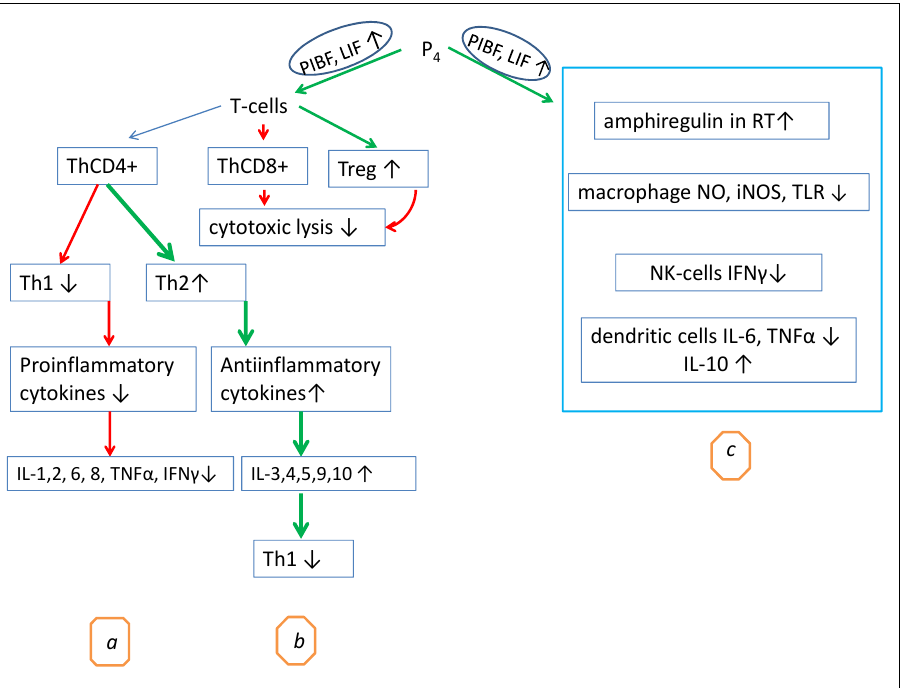
Figure 1. The proposed mechanisms of the P4 immunomodulatory effects. ( a ) P 4 induces PIBF and LIF production, which inhibit the Th1 pathway and reduce the production of proinflammatory cytokines; ( b ) P 4 upregulates Th2 differentiation and anti-inflammatory cytokine synthesis, which downregulate Th1 differentiation; P 4 decreases CD8 + T cytotoxicity and upregulates Tregs, which also decrease CD8 + T cytotoxicity; ( c ) by stimulation of the secreting amphiregulin, P 4 activates proliferation and repair in the respiratory tract (RT). P 4 decreases the production of proinflammatory cytokines IFN- γ , IL-6, and TNF- ⍺ by NK (natural killer) and dendritic cells, as well as decreases NO synthesis by macrophages. Red arrow—inhibition, green arrow—stimulation.